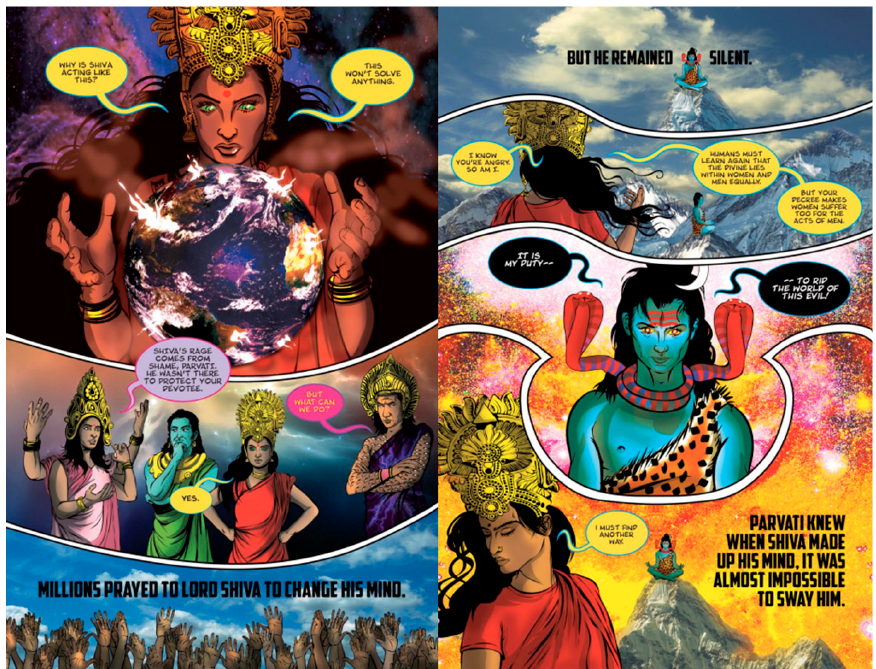
Figure 9. A panel from the Priya’s Shakti comic book in Parvati is frustrated that cannot convince Shiva to intervene. Image Courtesy: Ram Devineni.